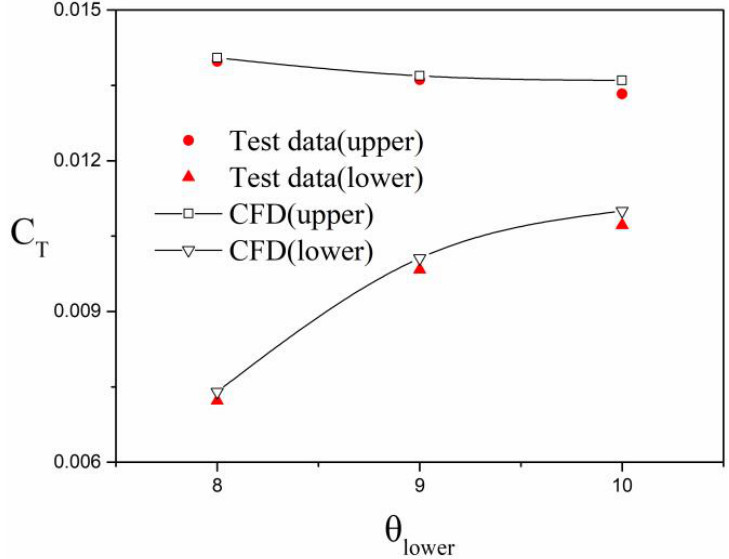
Figure 14. The thrust coefficient of the upper and lower rotors varies with the collective pitch of the lower rotor.